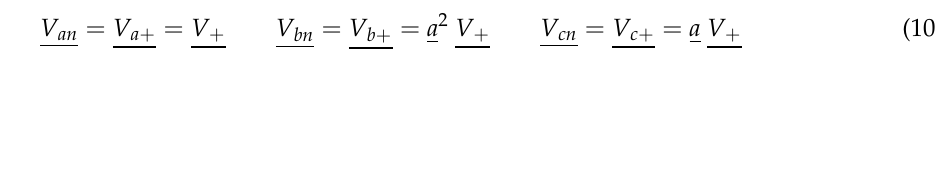
Figure 3. Compensation of zero-sequence currents.